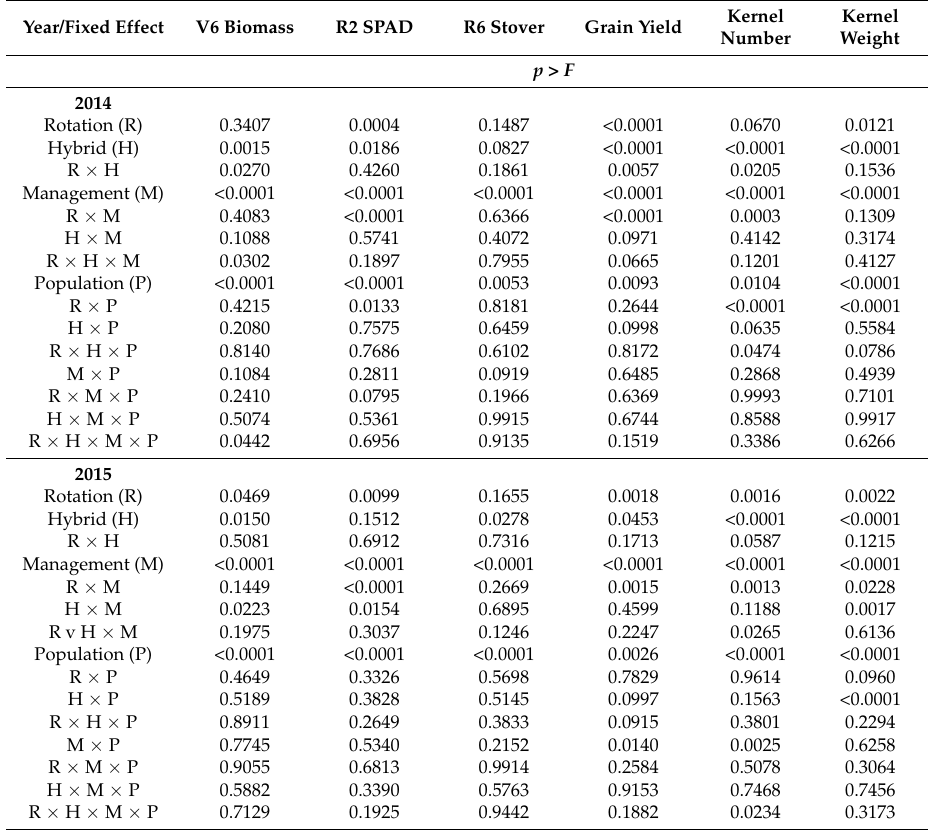
Table 2. Tests of fixed sources of variation on early and late season biomass accumulation, in-season leaf greenness, final grain yield, and yield components for the continuous corn trial conducted at Champaign, IL during 2014 and 2015. Rotation (R), hybrid (H), management (M), and population (P) served as fixed